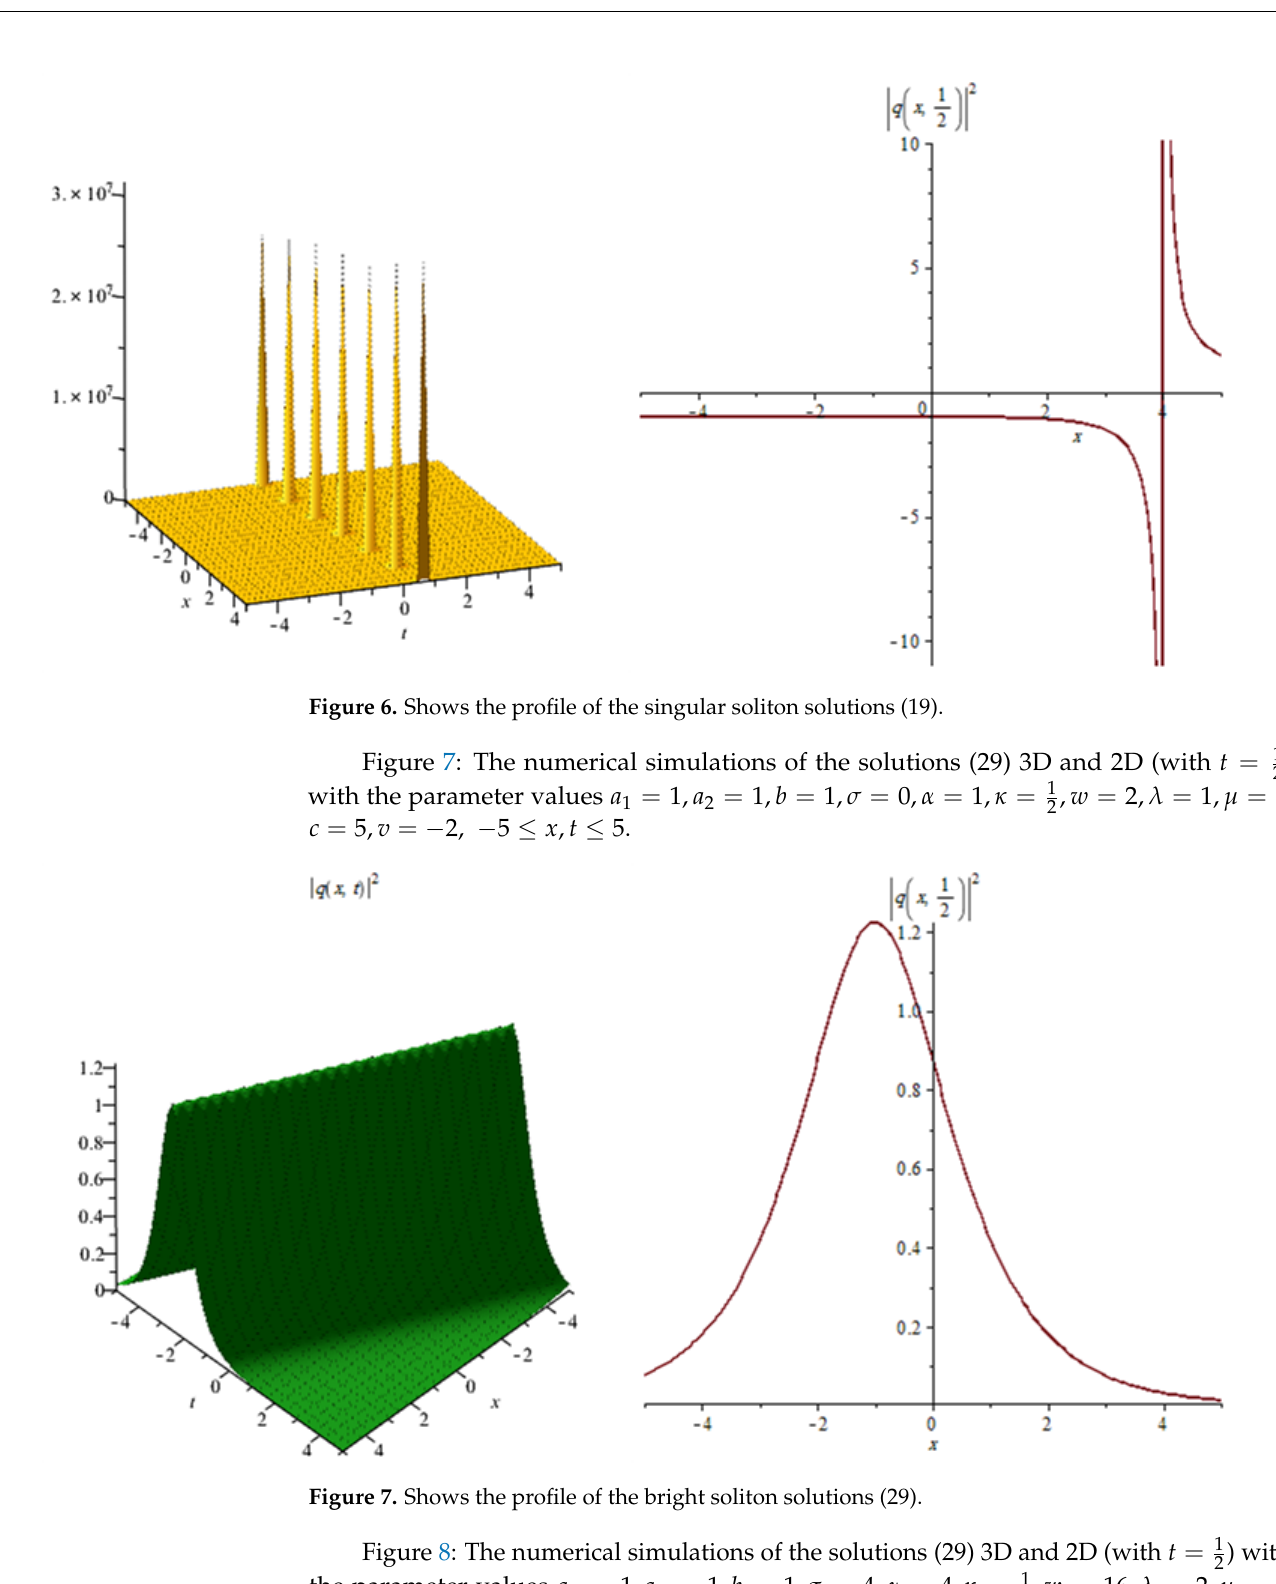
) with 2 , w = 16, λ = 2, µ = 2, 4